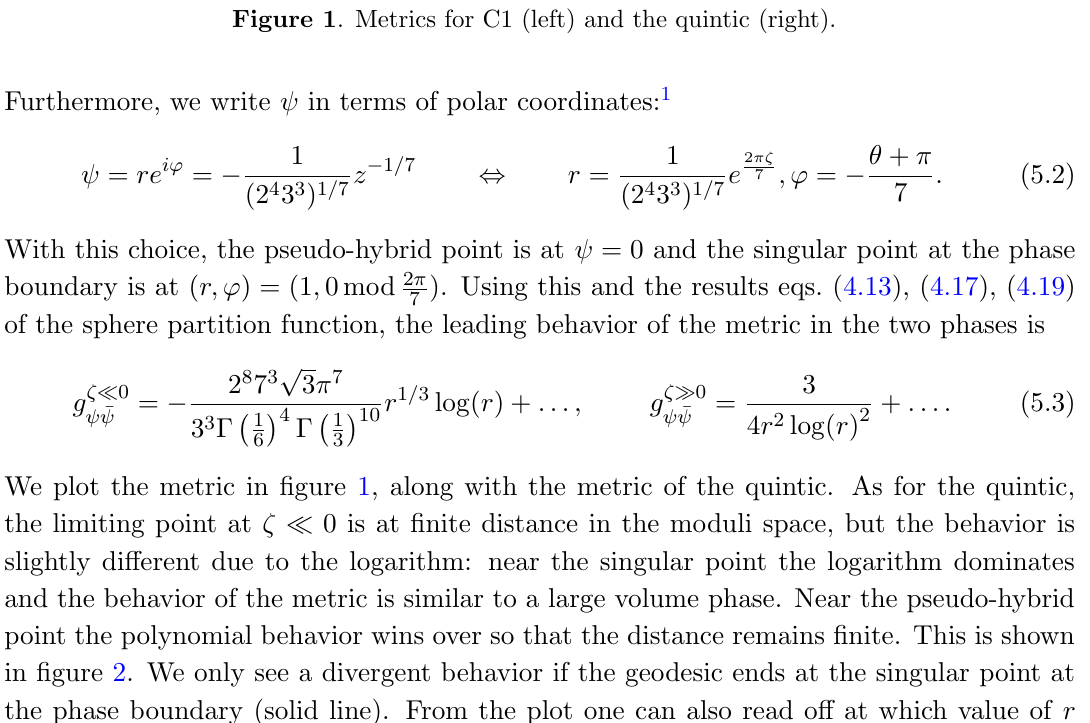
Figure 1 . Metrics for C1 (left) and the quintic